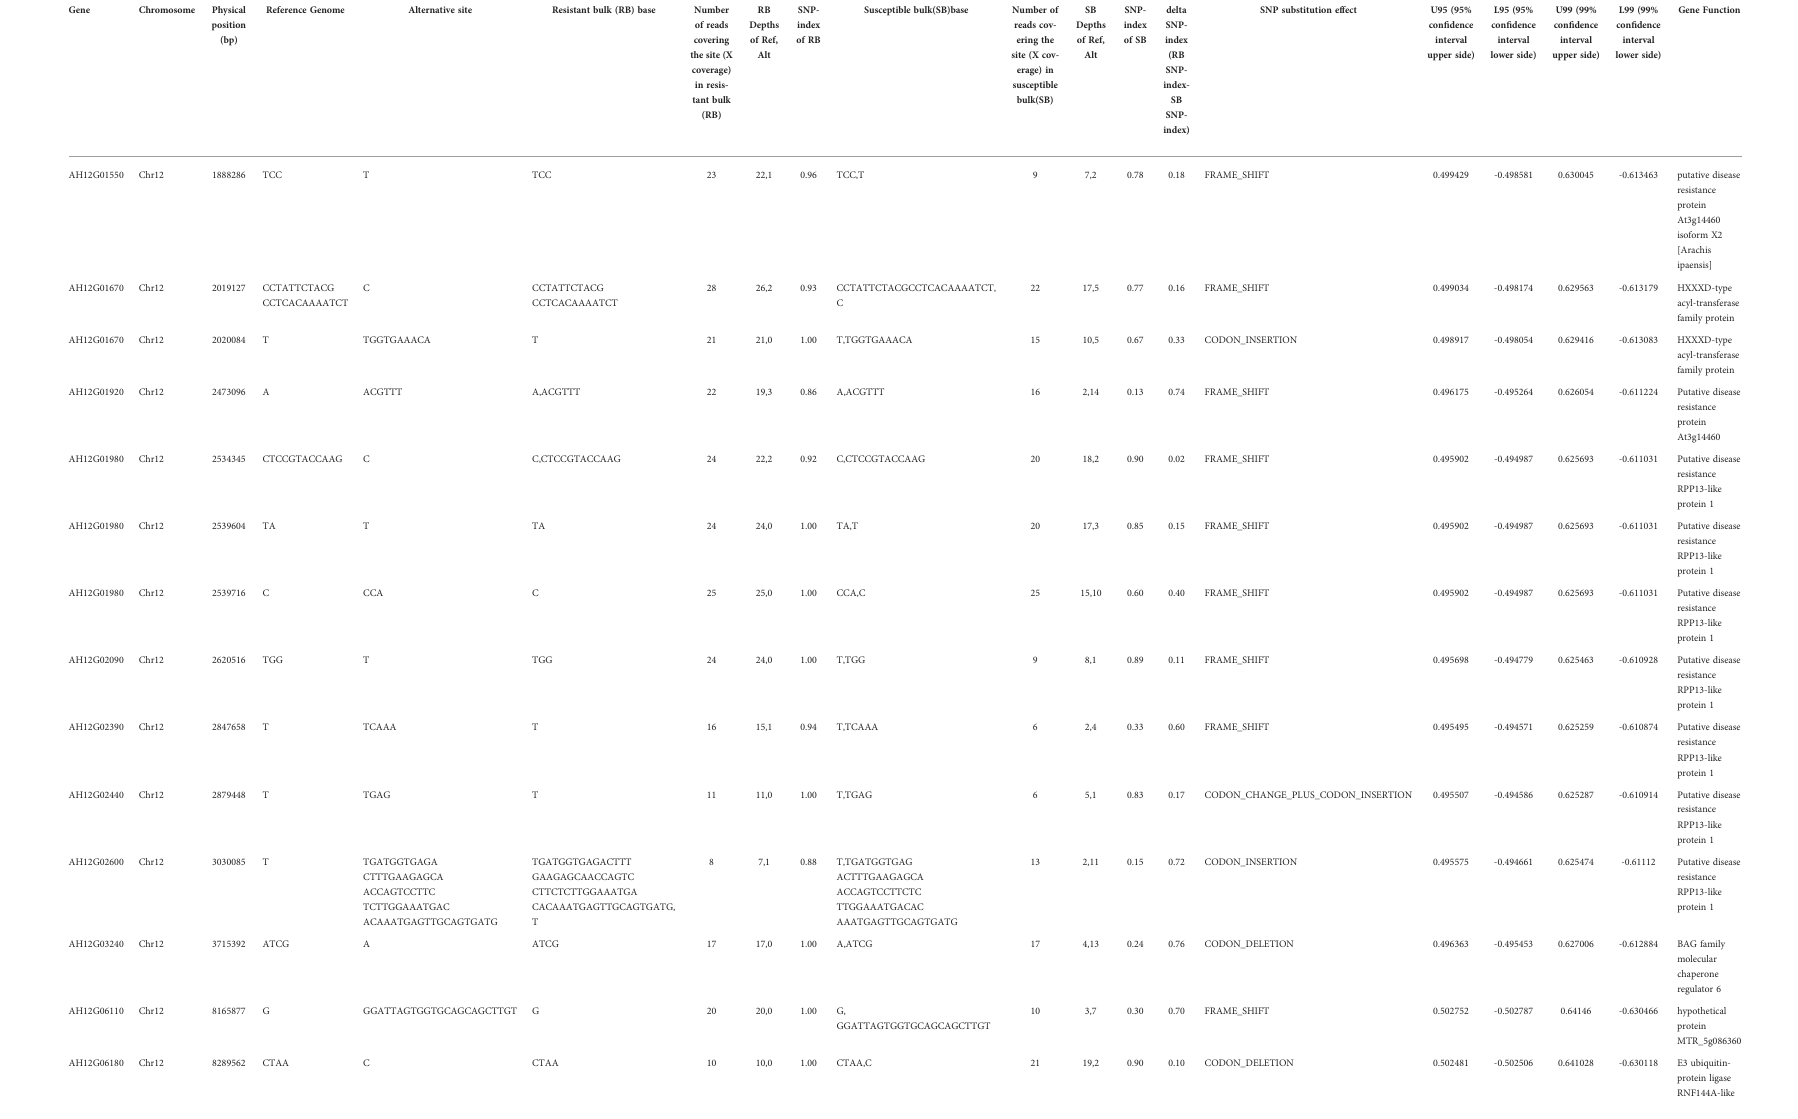
TABLE 3 Identi fi cation of InDels in putative candidate genes in the genomic region for resistance to on chromosome 12.